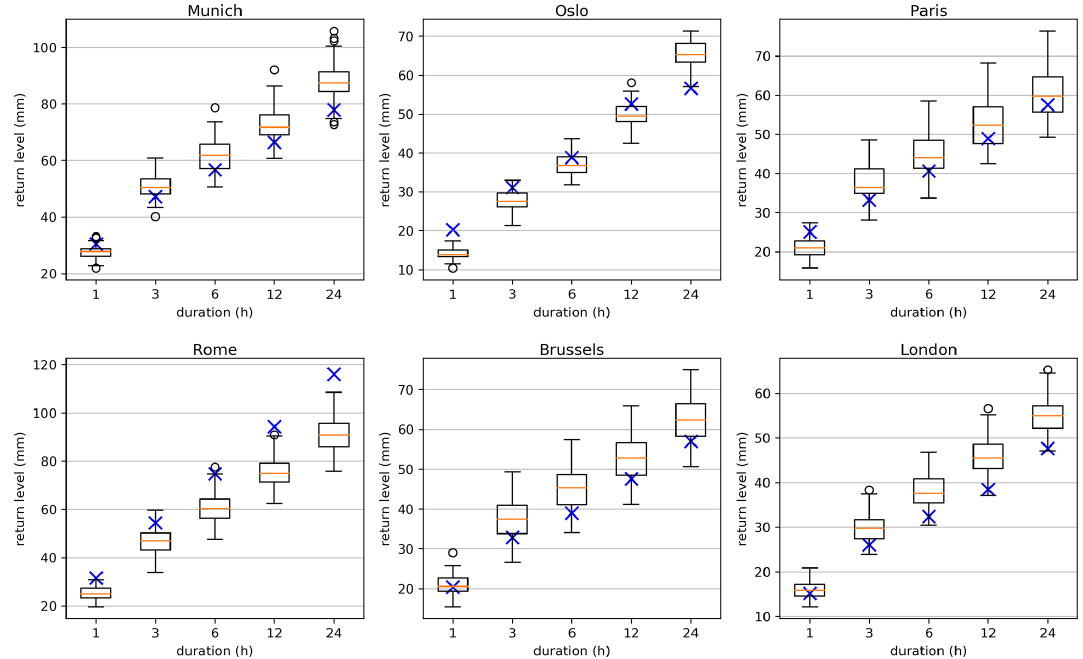
Figure 6. The range of the 10-year return levels of the CRCM5-LE at six cities is shown as box plots, where the median corresponds to the orange line. The boxes are defined by the first and third quartiles. Outliers exceed the first or third quartile plus 1.5 times the interquartile range. They are depicted as black circles. The observational return levels are marked as blue